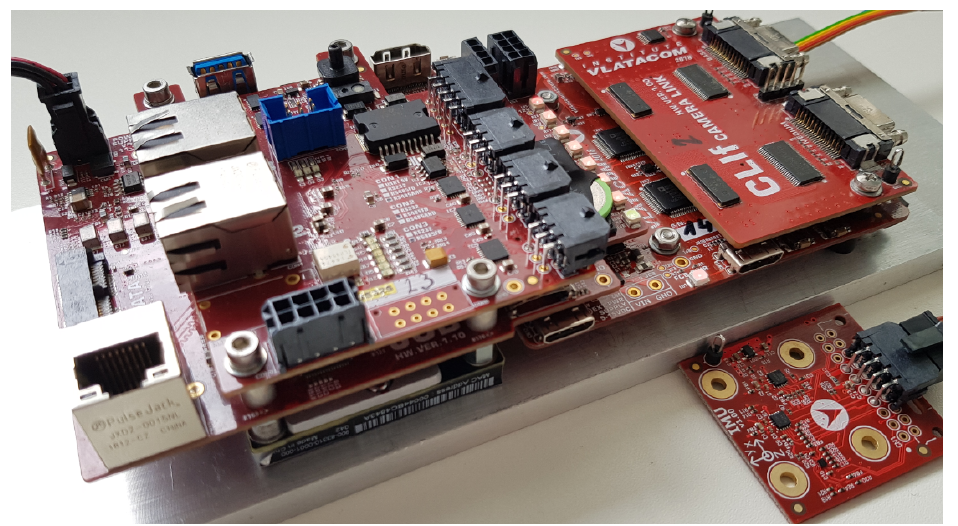
Figure 13. VVSP module with connected IMU sensor .